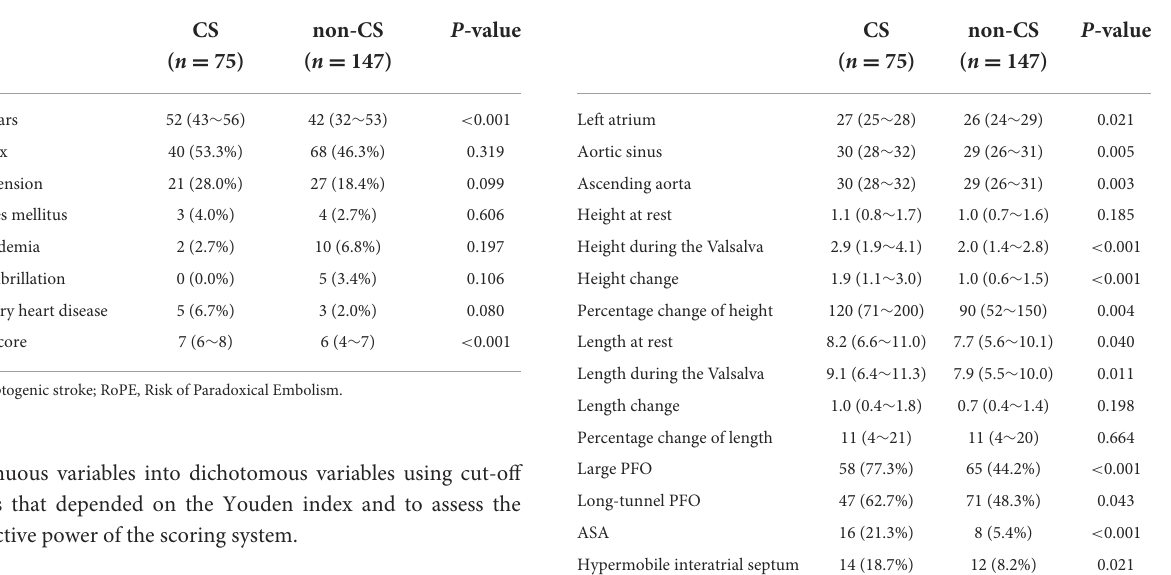
TABLE 1 Clinical characteristics of patients. TABLE 2 Echocardiographic PFO characteristics.